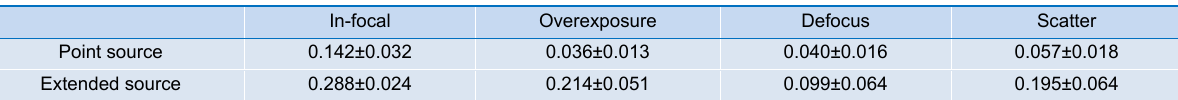
Table 6 | Summary of accuracies (RMSE:λ) of Zernike coefficients estimated by Xception. Table reproduced from ref. 83 , Optical Society of America.